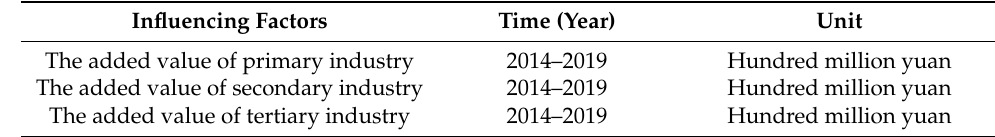
Table 2. Type of